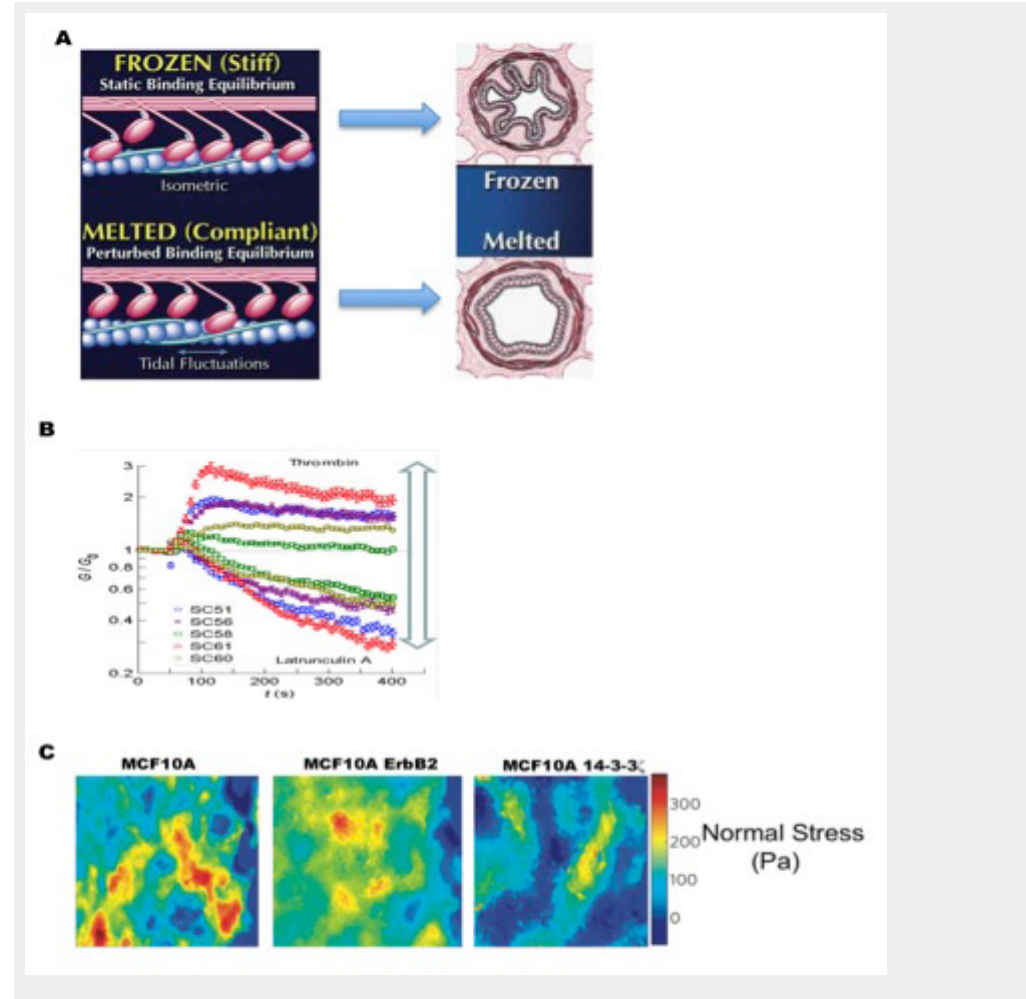
Bridging the gap between cell mechanics and health. (A) In asthma the ability of the ASM properly to fluidise and resolidfy is disturbed: actin-myosin contractility is abnormal since more myosin remains attached to actin filaments at any given time, resulting in the airway being in a “frozen” state. However, in normal ASM less myosin is attached to actin filaments, allowing the airways to more readily deform at will, representing a “melted” state. (B) Schlemm’s canal cells treated with drugs known to decrease or increase aqueous humour outflow resistance surprisingly had equivalent effects on cell stiffness, providing possible therapeutic opportunities for sufferers of glaucoma. (C) The normal stress distribution of the MCF10A breast cancer cell line over-expressing the oncogenes ErbB2 (HER-2/Neu) or 14-3-3ζ, or vector (control) were observed to be remarkably distinct among one another. Cell lines expressing each oncogene reflected contrasting epithelial (ErbB2 (HER-2/ Neu)) and mesenchymal (14-3-3ζ) cell behaviours. Adapted with permission from Tambe et al. Nat Mater. 2011;10(6):469–7 [14], and reprinted from J Allergy Clin Immunol, 106(4), Fredberg JJ. Frozen objects: small airways, big breaths, and asthma, pp 615–24, Copyright (2000), with permission from Elsevier